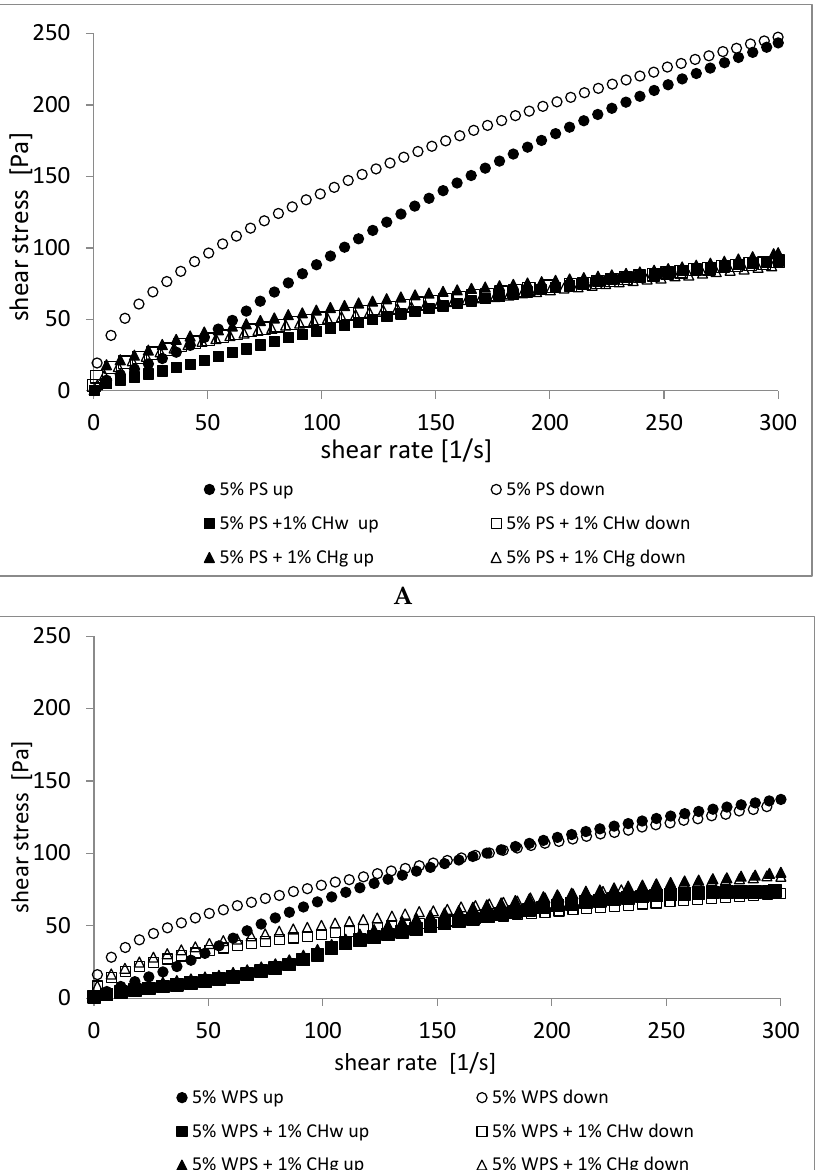
Figure 2. Flow curves of ( A ) 5% PS pastes and its mixtures with 1% CH (whole and ground) and ( B ) 5% WPS pastes and its mixtures with 1% CH (whole and ground). “Up” and “down” mean curves of a hysteresis loop in the range of shear rates 0–300 s − 1 and 300–0 s − 1 , respectively. Results showed that the shear stress of starch-chia mixtures decreased distinctly compared to starch alone, which meant that the apparent viscosity also lowered. According to Campanella et al. (1995) [60], such behavior may be because as the shear rate increases, the polymers disintegrate (colloidal aggregation breaks down) and causes less resistance.